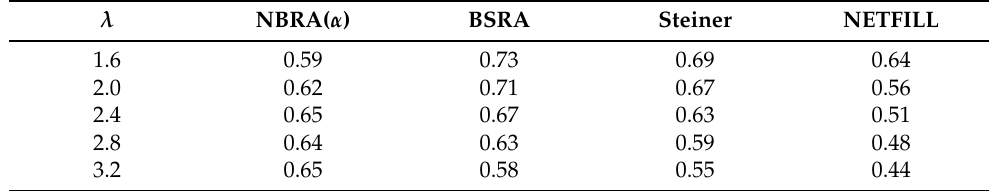
Table 3. Recovery probabilities of four algorithms: (i) NBRA( α ), (ii) BSRA, (iii) Steiner, and (iv) NETFILL as varying the ER graph parameter λ